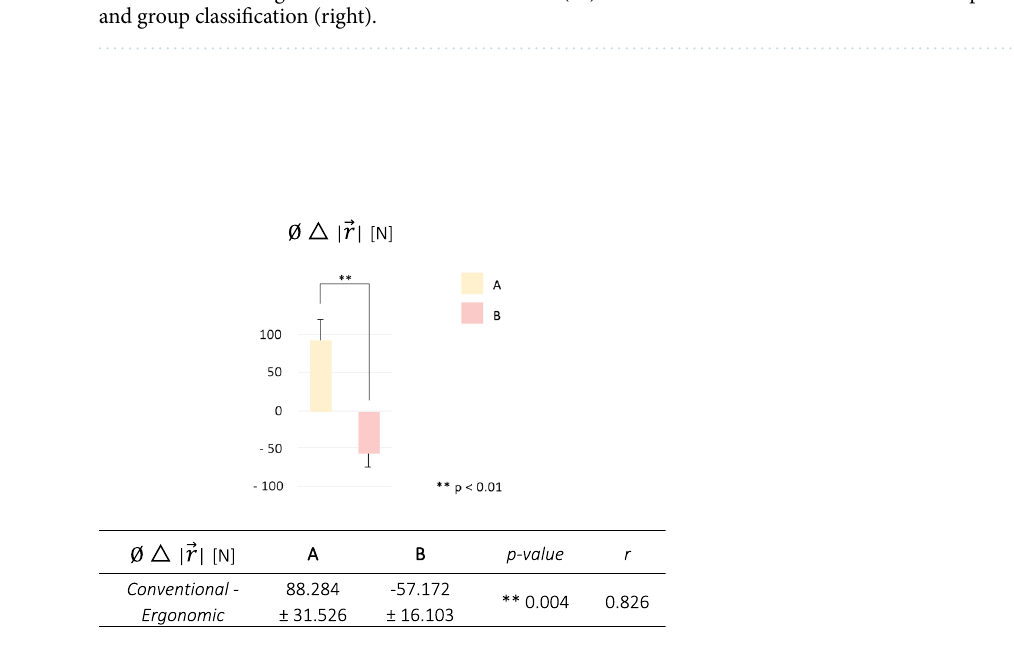
−→ r | while working ergonomically.